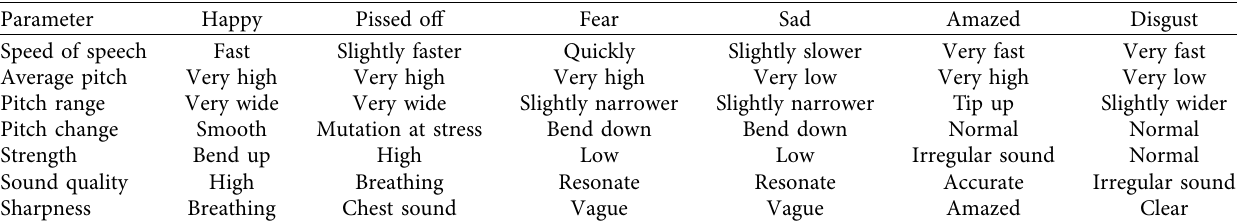
Figure 1: English speech recognition emotion interaction mode under virtual Table 1: Emotional and speech emotional features.